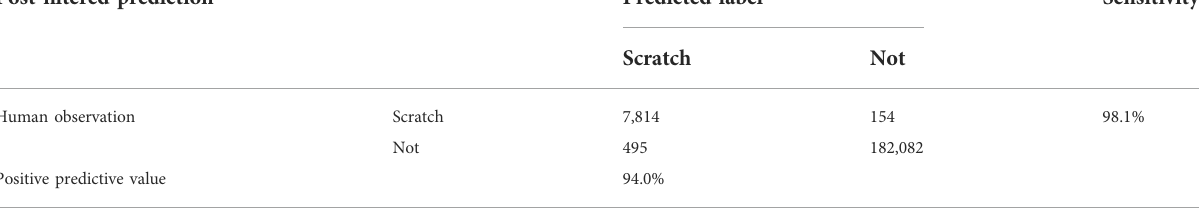
TABLE 1 Confusion matrix of post- fi ltered CRNN prediction for the test